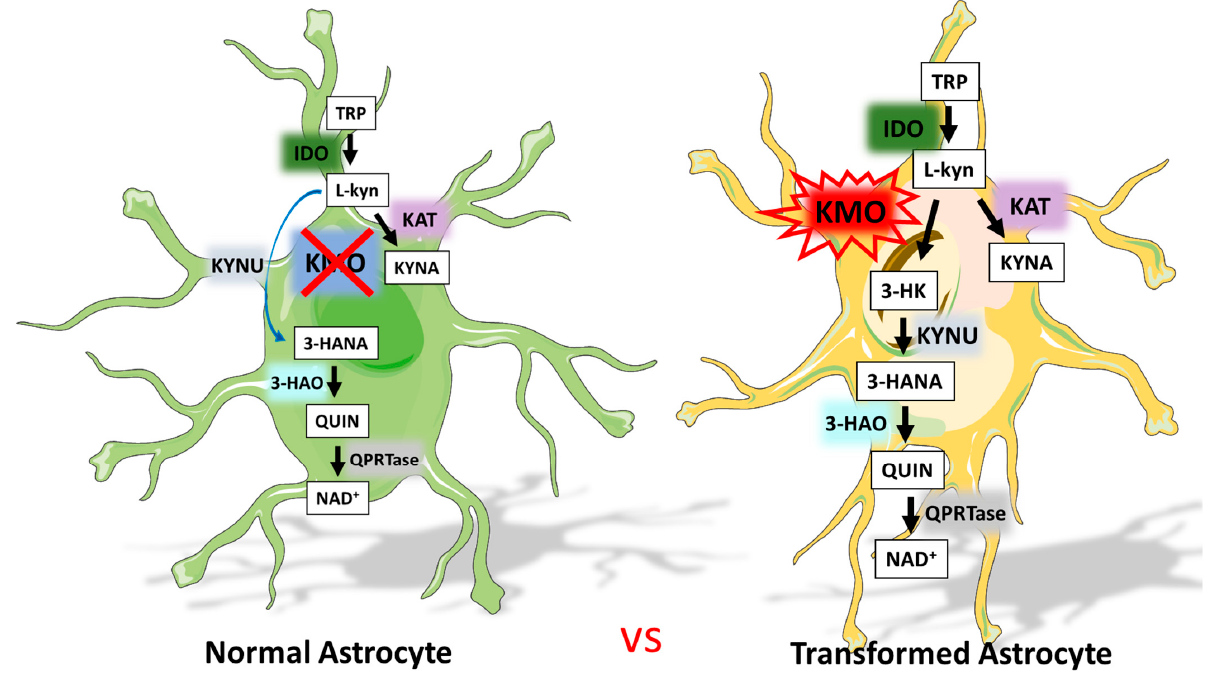
Figure 6. Tryptophan catabolism through the KP in normal astrocytes vs. transformed astrocytes. These findings of KMO expression and activity in GBM cells represent a novel phenotypic characteristic that makes them different from normal astrocytes, which do not express KMO. In accordance with this, human fetal astrocytes were unable to produce 3- HK and KMO mRNA expression was not detected, even when they were stimulated with cytokines. However, KAT, 3-HAO, QPRT, and KYNU were expressed in human astrocyte cultures, indicating that KMO is the only KP enzyme that is not present in this cell type [52,53]. This change in KMO expression could be a consequence of the de-differentiation